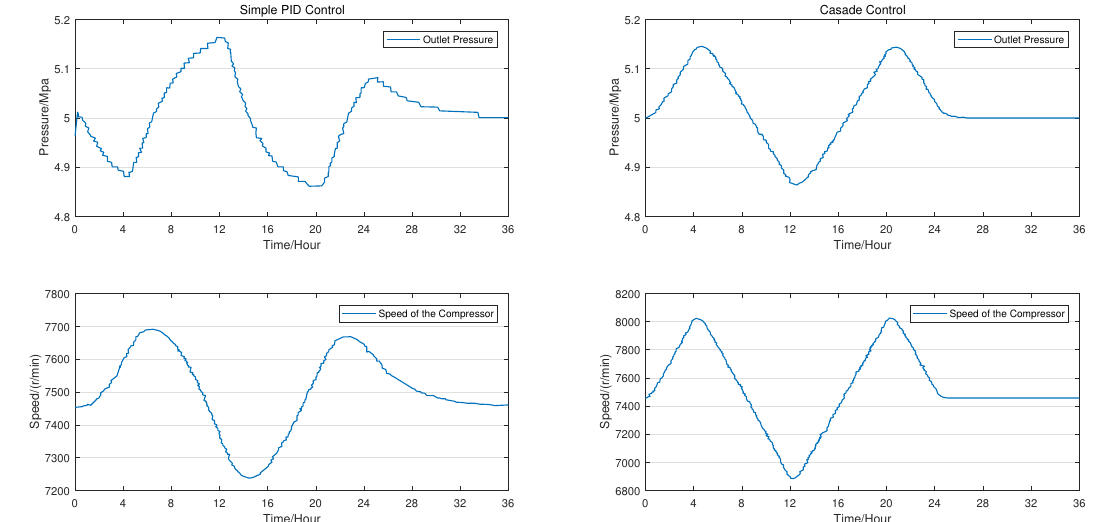
Figure 6. Comparison of compressor speed and outlet pressure under different control